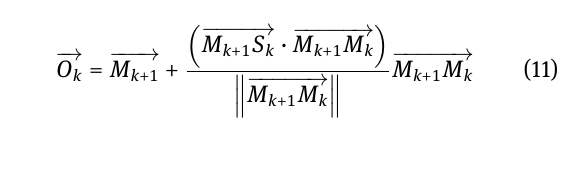
Fig. 16. Setting of Projection Screen and Movement of Robot in Mobile Walking Trainer −→ −−−→ position M k and M k +1 as follows: